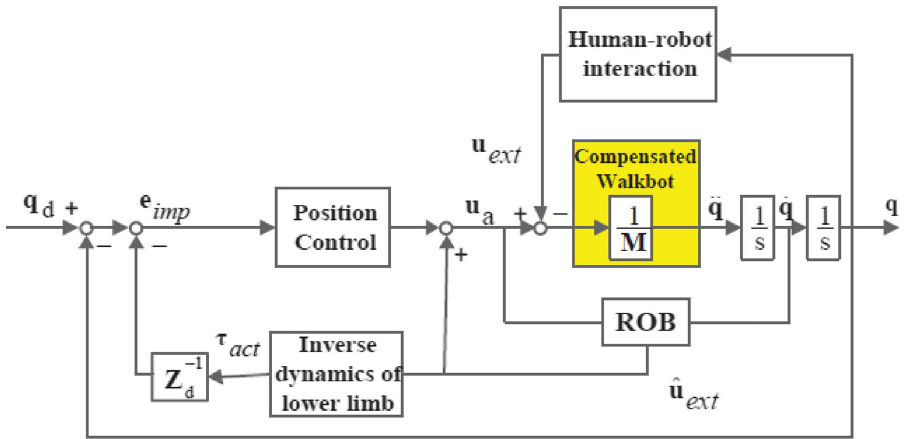
Figure 1. The control scheme of the position-based impedance control for gait rehabilitation. ROB reaction torque